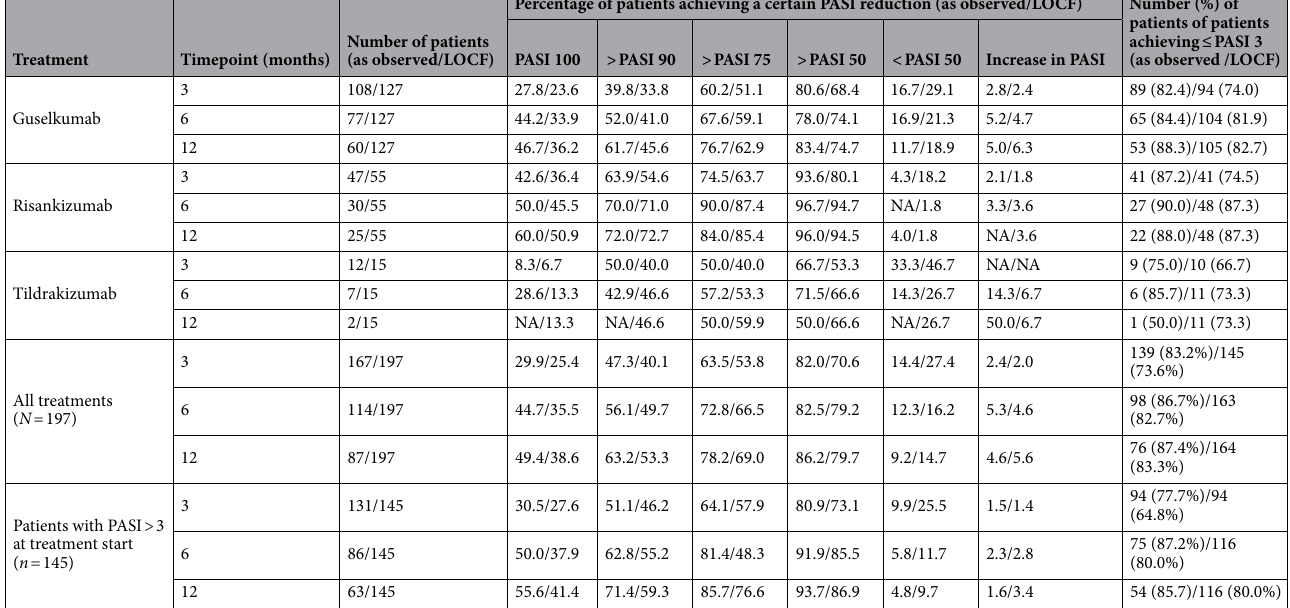
Table 5. Achievement of treatment goals. In 52 patients, the PASI at baseline was ≤ 3, of whom 9 had a PASI ≤ 1 at baseline. The number (%) of those patients achieving a PASI ≤ 1 as observed/LOCF was 32 (69.6)/32